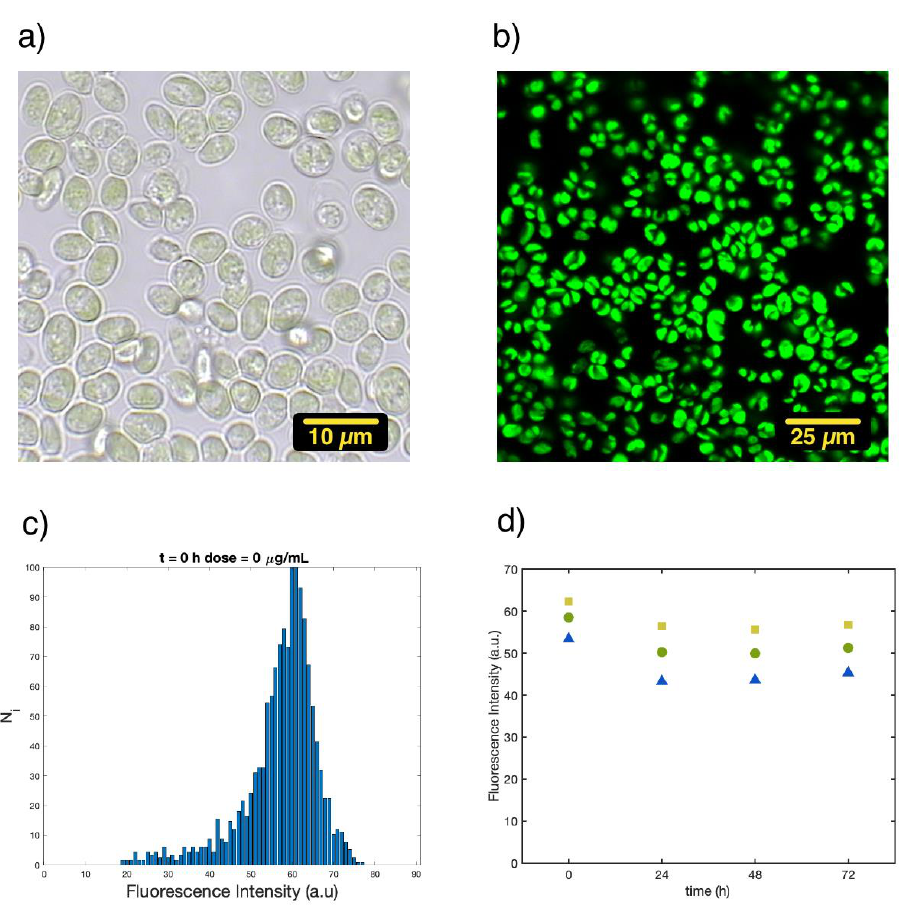
Figure 1. All pictures refer to a sample of C. cimbrica in buffer solution at room temperature: ( a ) transmission image recorded with white light (Batch 3), ( b ) spontaneous fluorescence emission excited at 410 nm (Batch 3), ( c ) histogram of the average fluorescence intensity of each single cell measured in pictures analogous to 1b (Batch 1), ( d ) 25th (blue triangles), 50th (green circles), and 75th (yellow squares) percentiles for the distribution of the average fluorescence intensity per single cell as a function of time (Batch 1).